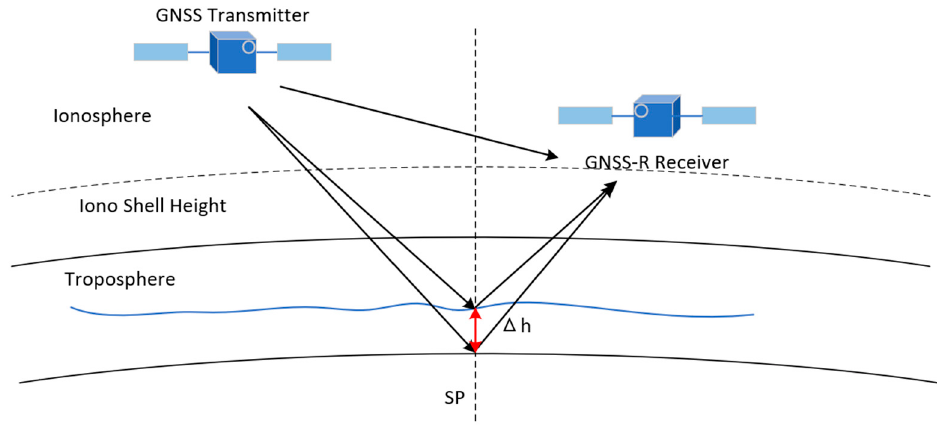
Figure 4. Spaceborne ocean altimetry geometric model.